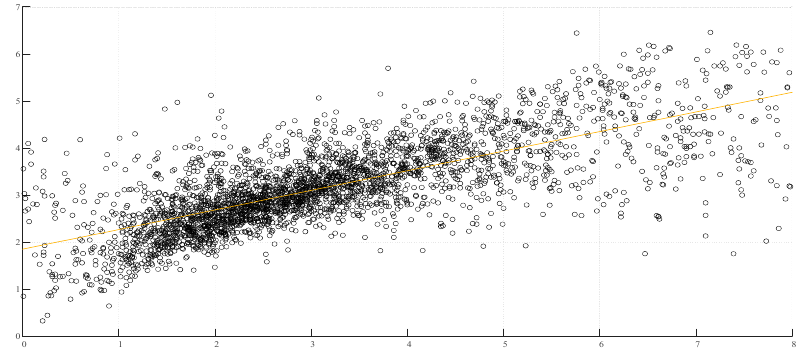
Figure 12. Calculation results based on random forest (cleaning rate